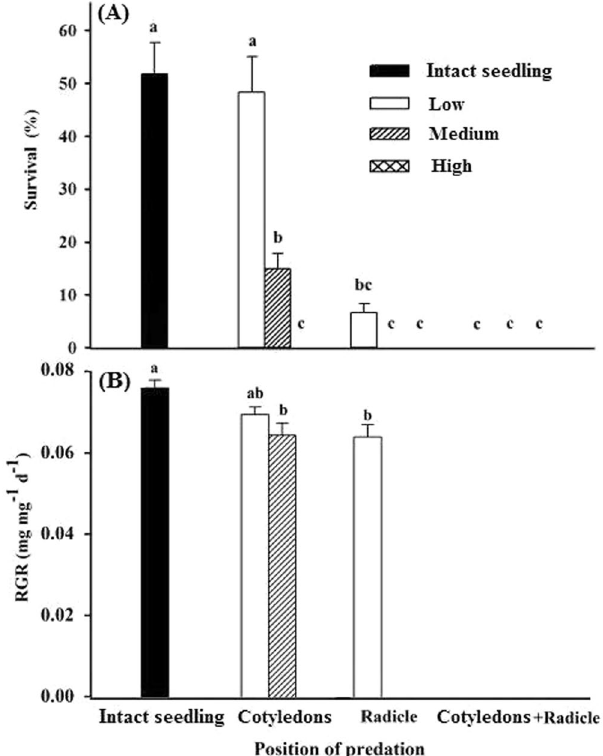
Figure 3. Effect of seed predation class on seedling survival ( A ) and relative growth rate (RGR) ( B ) (mean + se) in Astragalus lehmannianus . Intact seedlings germinated from scarified seeds, and thus neither the cotyledons nor radicle was damaged by predators. Bars with different lowercase letters are significantly different ( P < 0.05).